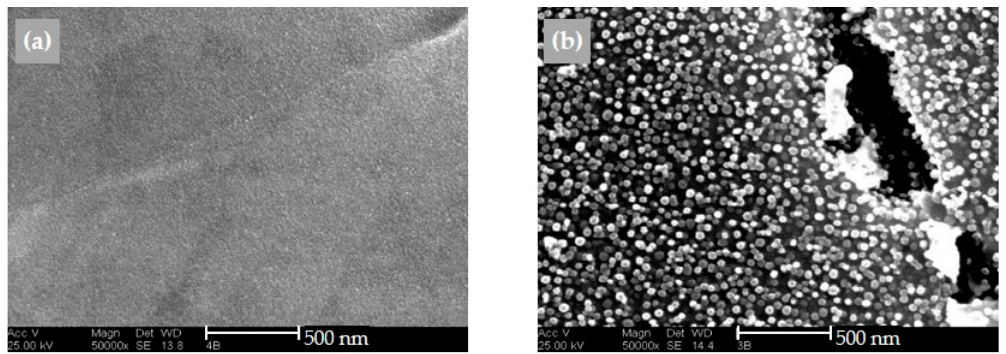
Figure 18. SEM micrographs of specimens, welded with shielding gas Z-ArHeHC. ( a ) as-built; ( b ) precipitation hardened (etching solution: 15 g CrO 3 + 150 mL H 3 PO 4 + 100 mL H 2 SO 4 ).